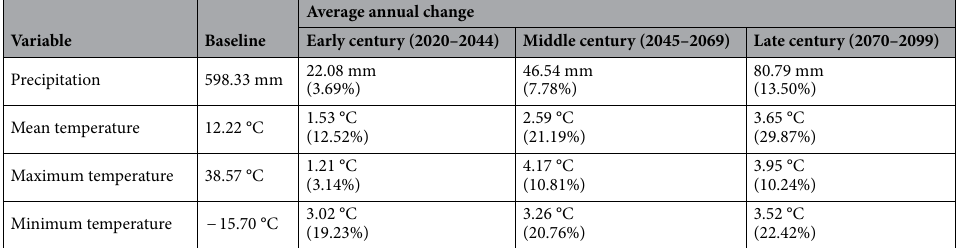
Table 1. Average annual change in precipitation, mean temperature, daily maximum temperature, and daily minimum temperature across five GCMs in three future periods related to the baseline period in the TMC.